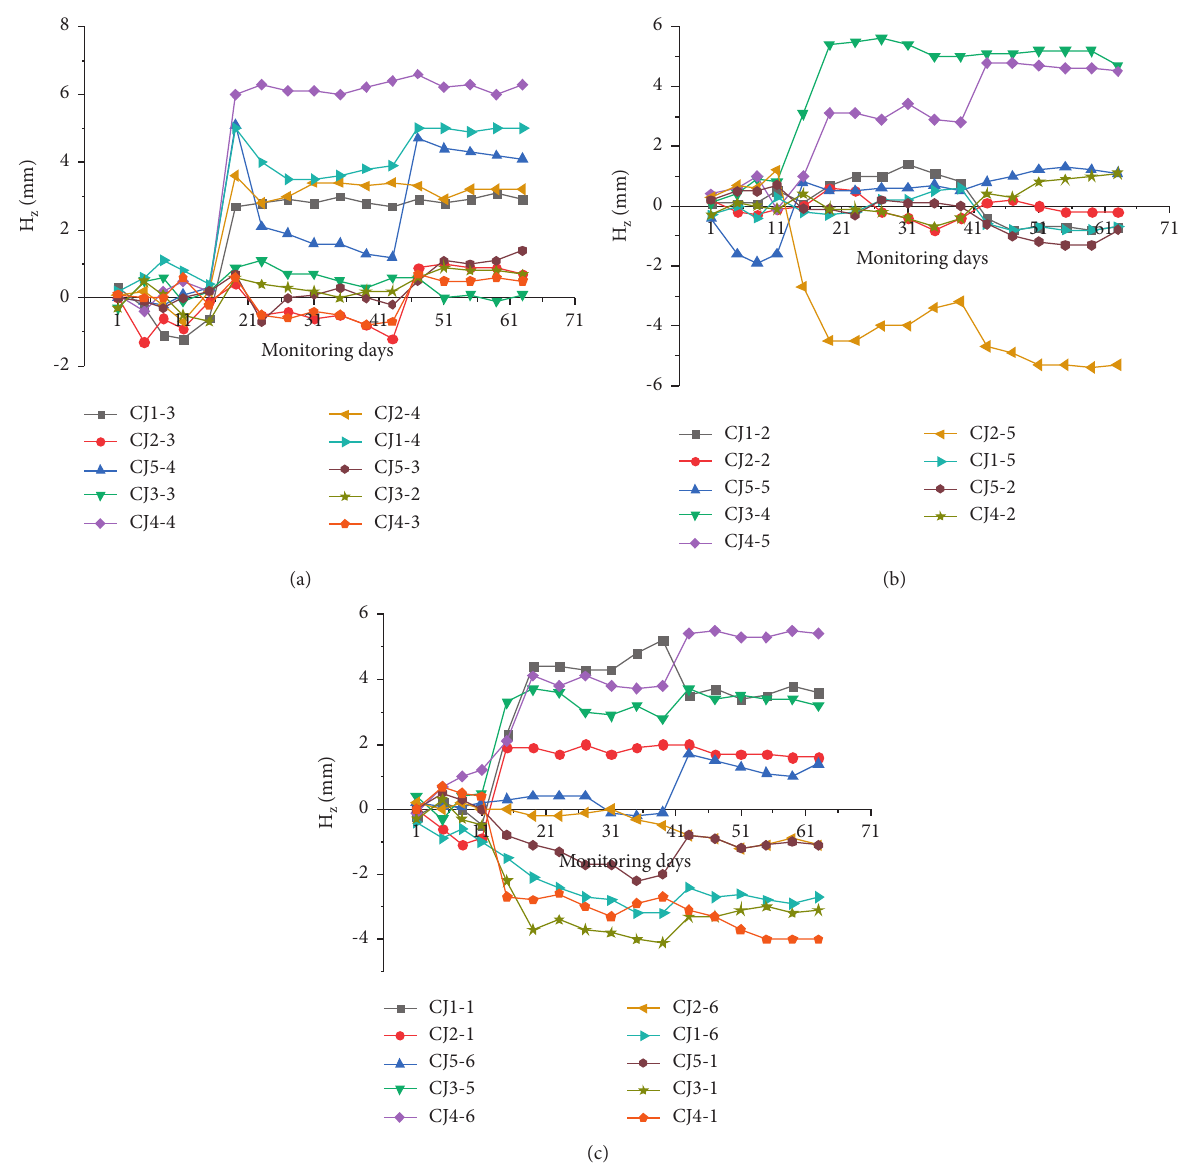
Figure 8: Change curve of surface settlement. (a) First ring. (b) 2nd ring. (c) 3rd